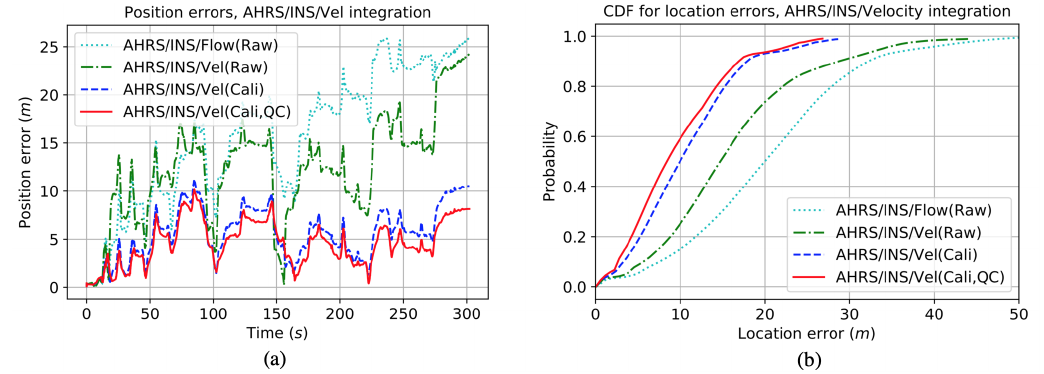
Figure 8. ( a ) AHRS/INS/Velocity integrated location errors with various velocity strategies and ( b ) their cumulative distribution function (CDF). Table 2. Statistics of AHRS/INS/Velocity integrated location errors, with various velocity strategies. Strategy